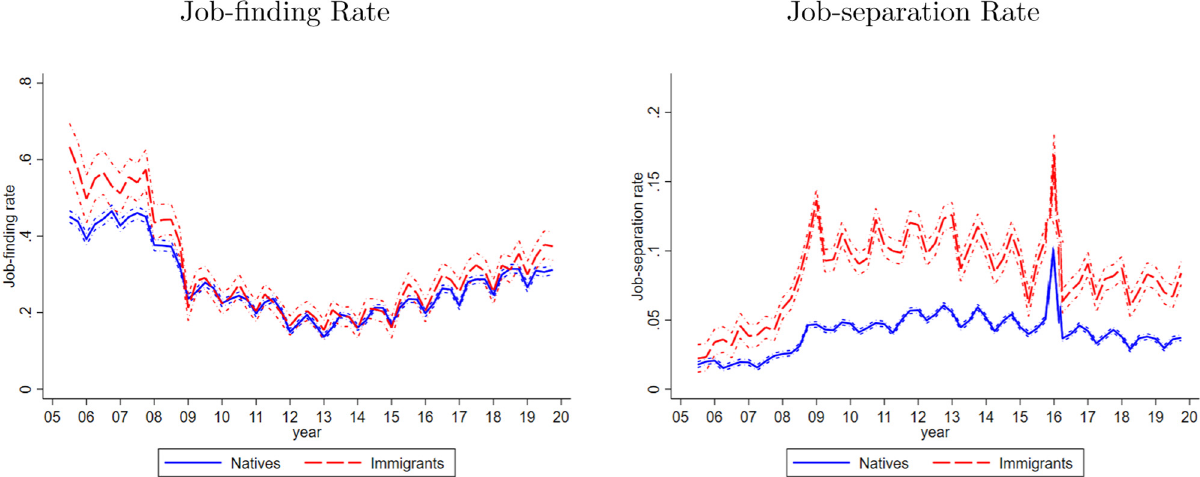
Figure A15: Conditional labour market transitions by nationality using quarter dummies. Note: The fi gure plots the residuals ( evaluated at the average at means of other covariates ) obtained from the estimation of equations ( 3 ) and ( 4 ) using a linear probability model, but interacting the variable imm i with quarter dummies instead of year dummies. Both regressions include controls for education, potential experience, marital status, age, gender, region of residence, sector of activity, occupation, type of contract ( permanent or temporary ) , type of job ( full or partial time ) , tenure, and quarter dummies. Equations ( 3 ) and ( 4 ) are estimated using 339,008 and 1,559,302 observations, respectively. Source: Spanish Labour Force Survey - Flows ( 2005 – 2015 ) .